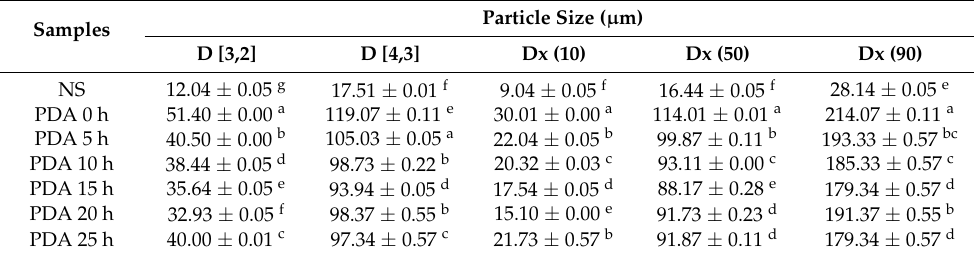
Figure 2. Particle size of purple sweet potato native and debranched at different times combined with autoclaved starches. NS, PDA 0 h, PDA 5 h, PDA 10 h, PDA 15 h, PDA 20 h, and PDA 25 h indicate native starch, pullulanase debranching in different treatment times combined with autoclaving starch. Table 1. Particle size of native and debranched combined with autoclaved starches.